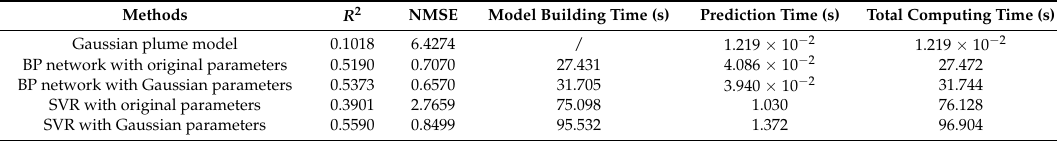
Table 3. Prediction performances of proposed ML models on the Indianapolis test